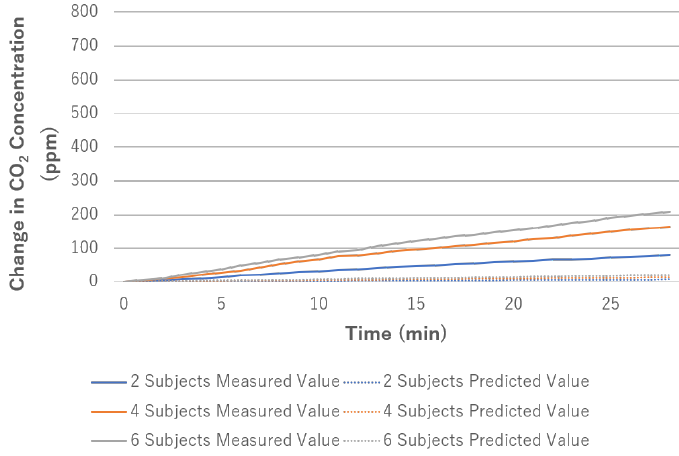
Figure 15. Predicted and measured values of CO 2 concentration in the large studio (2, 4, 6